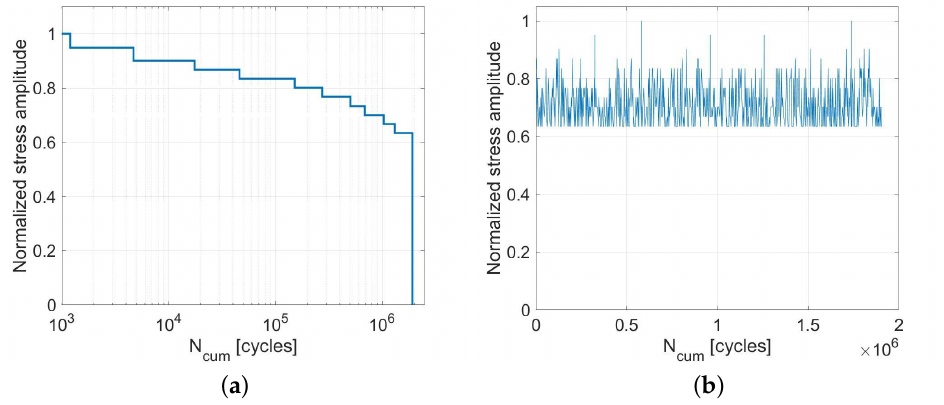
Figure 3. Applied load spectra derived from in-service loading condition: ( a ) normalized load spectrum and ( b ) applied load